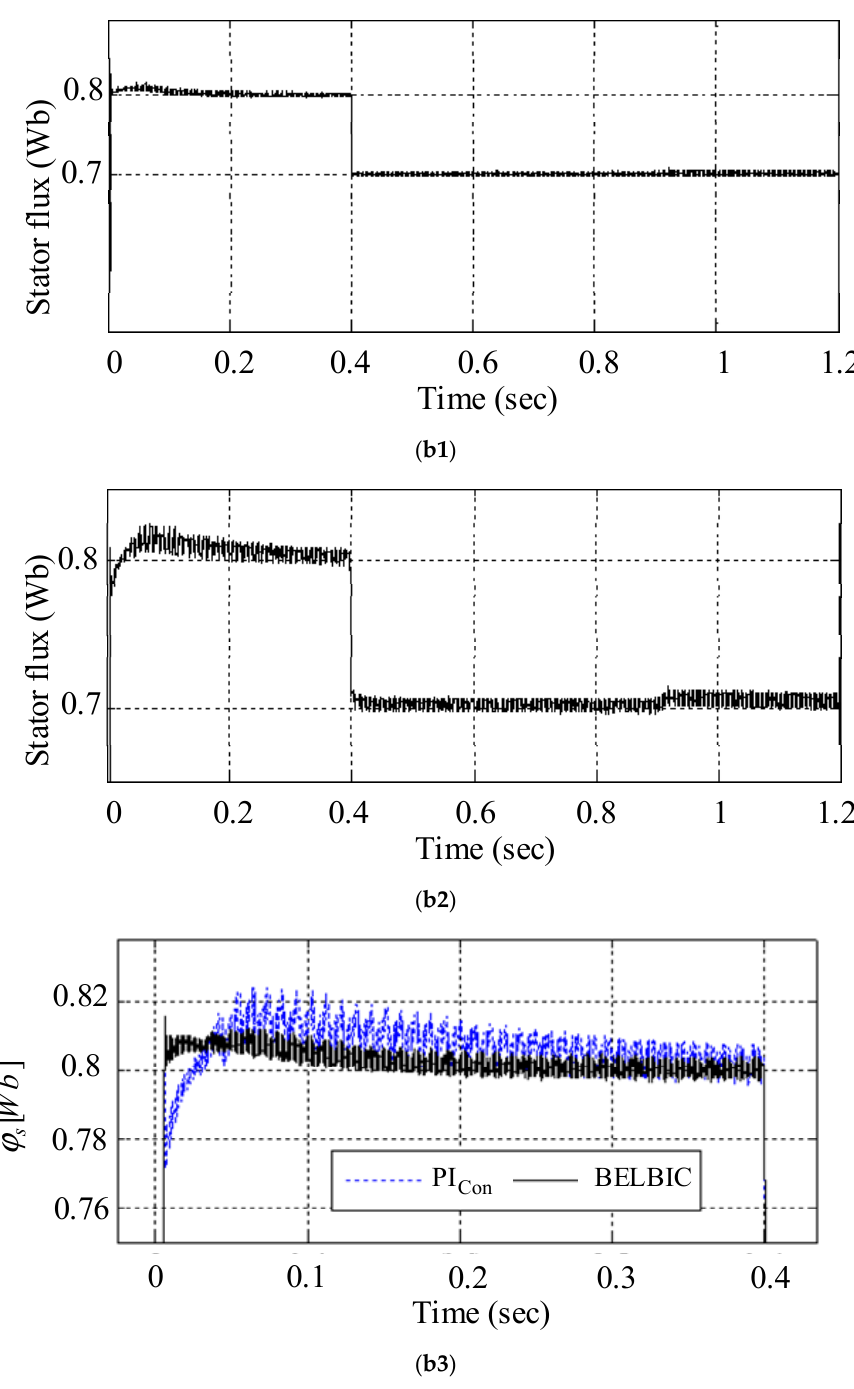
Figure 11. Control of velocity and flux using BELBIC and the conventional PI controller regulated by GA. ( a ) BELBIC electromagnetic torque, ( b1 ) the magnetic flux of the stator, ( b2 ) using the proposed method, ( b3 ) the conventional method [36].